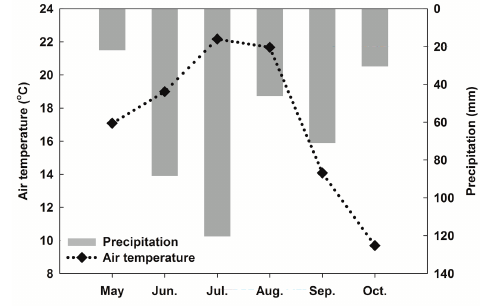
Figure 2. Monthly mean precipitation and air temperature during the experimental period [ 34 ].